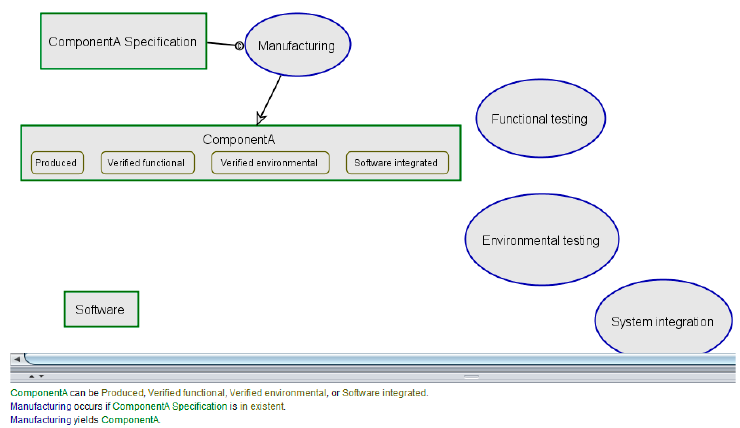
Figure 3. Linking objects and process, option #2.